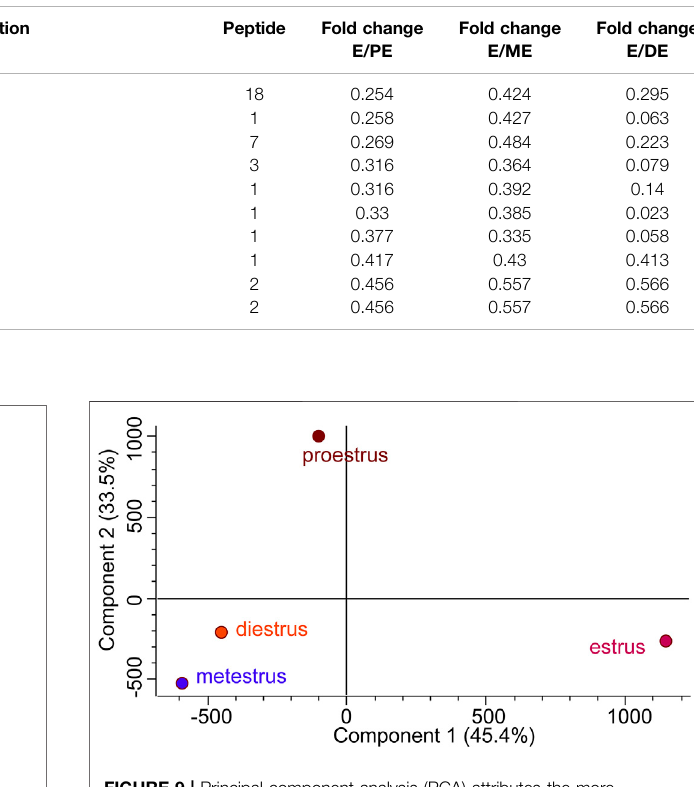
FIGURE 9 | Principal component analysis (PCA) attributes the more differencebetweenestrusand othernon-estrusstages(proestrus,metestrus, and diestrus).